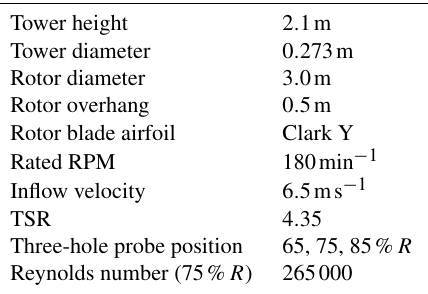
Table 2. Summary of the turbine